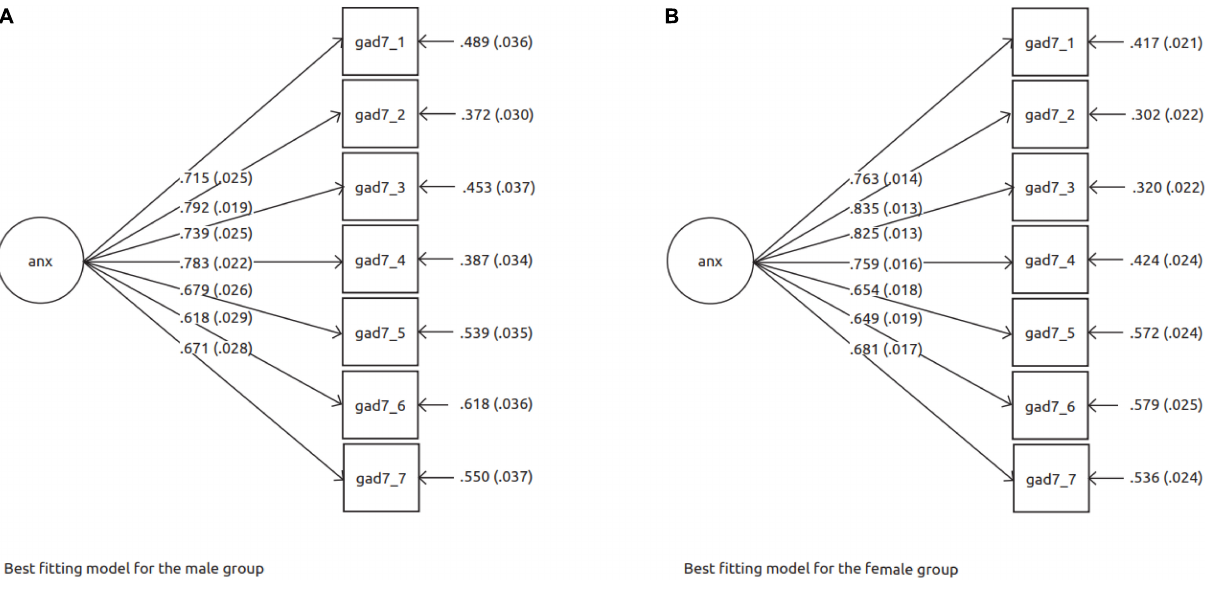
FIGURE 2 | Best fitting models for the measuring instrument of anxiety (GAD-7). (A) Best fitting model for the male group. (B) Best fitting model for the female